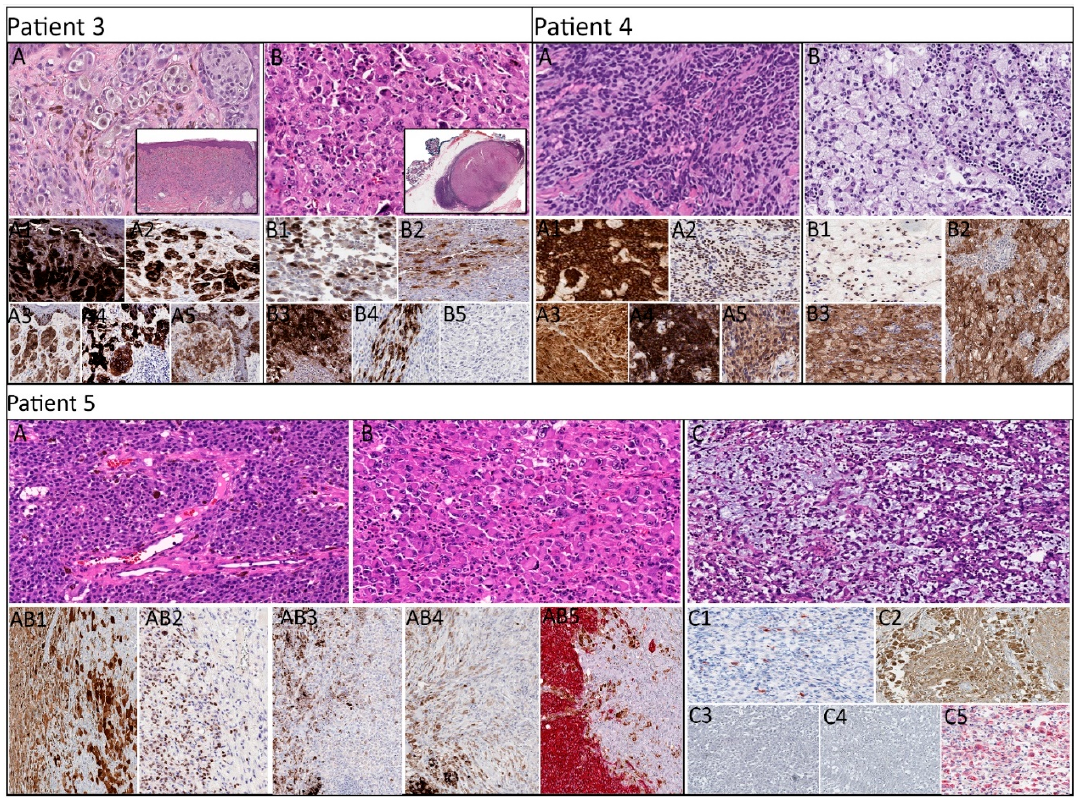
Figure 2. Morphologic and immunohistochemical expression of paired lesions in patient 3–5. Patient 3: primary cutaneous melanoma with epithelioid morphology ( A ) and histiocytoid morphology of intraparotid lymph node metastasis ( B ) (H&E, × 400; inset, × 20) exhibiting di ff use expression of S100 ( A1 ), SOX10 ( A2 ), pan-melanocytic cocktail ( A3 ), HMB-45 antigen ( A4 ), and Melan-A ( A5 ) in the primary lesion and patchy expression of S100 ( B1 ), SOX10 ( B2 ), pan-melanocytic cocktail ( B3 ), focal expression of HMB-45 antigen ( B4 ), and negative expression of Melan-A ( B5 ) in the metastatic lesion (IHC, × 200). Patient 4: primary cutaneous melanoma with epithelioid morphology ( A ) and right groin lymph node with metastatic melanoma with histiocytoid morphology (H&E, × 400) exhibiting di ff use expression of S100 ( A1 ), SOX10 ( A2 ), pan-melanocytic cocktail ( A3 ), HMB-45 antigen ( A4 ), and Melan-A ( A5 ) in the primary lesion and di ff use expression of S100 ( B1 ), SOX10 (not shown), pan-melanocytic cocktail ( B2 ), and Melan-A ( B3 ) in the metastatic lesion (IHC, × 200). Patient 5: primary cutaneous melanoma with epithelioid ( A ) and rhabdoid ( B ) morphologies and in-transit metastasis with myxoid morphology ( C ) (H&E, × 400) exhibiting di ff use expression of S100 ( AB1 ), SOX10 ( AB2 ), pan-melanocytic cocktail ( AB3 ), HMB-45 antigen ( AB4 ), and Melan-A ( AB5 ) in the epithelioid region of primary lesion, patchy expression of S100 ( AB1 ), negative expression of SOX10 ( AB2 ), pan-melanocytic cocktail ( AB3 ), and HMB-45 antigen ( AB4 ), and focal expression of Melan-A ( AB5 ) in the rhabdoid region of the primary lesion, and focal expression of S100 ( C1 ), patchy expression of SOX10 ( C2 ), negative expression of pan-melanocytic cocktail ( C3 ) and HMB-45 antigen ( C4 ), and weak expression of Melan-A ( C5 ) in the metastatic lesion (IHC, ×